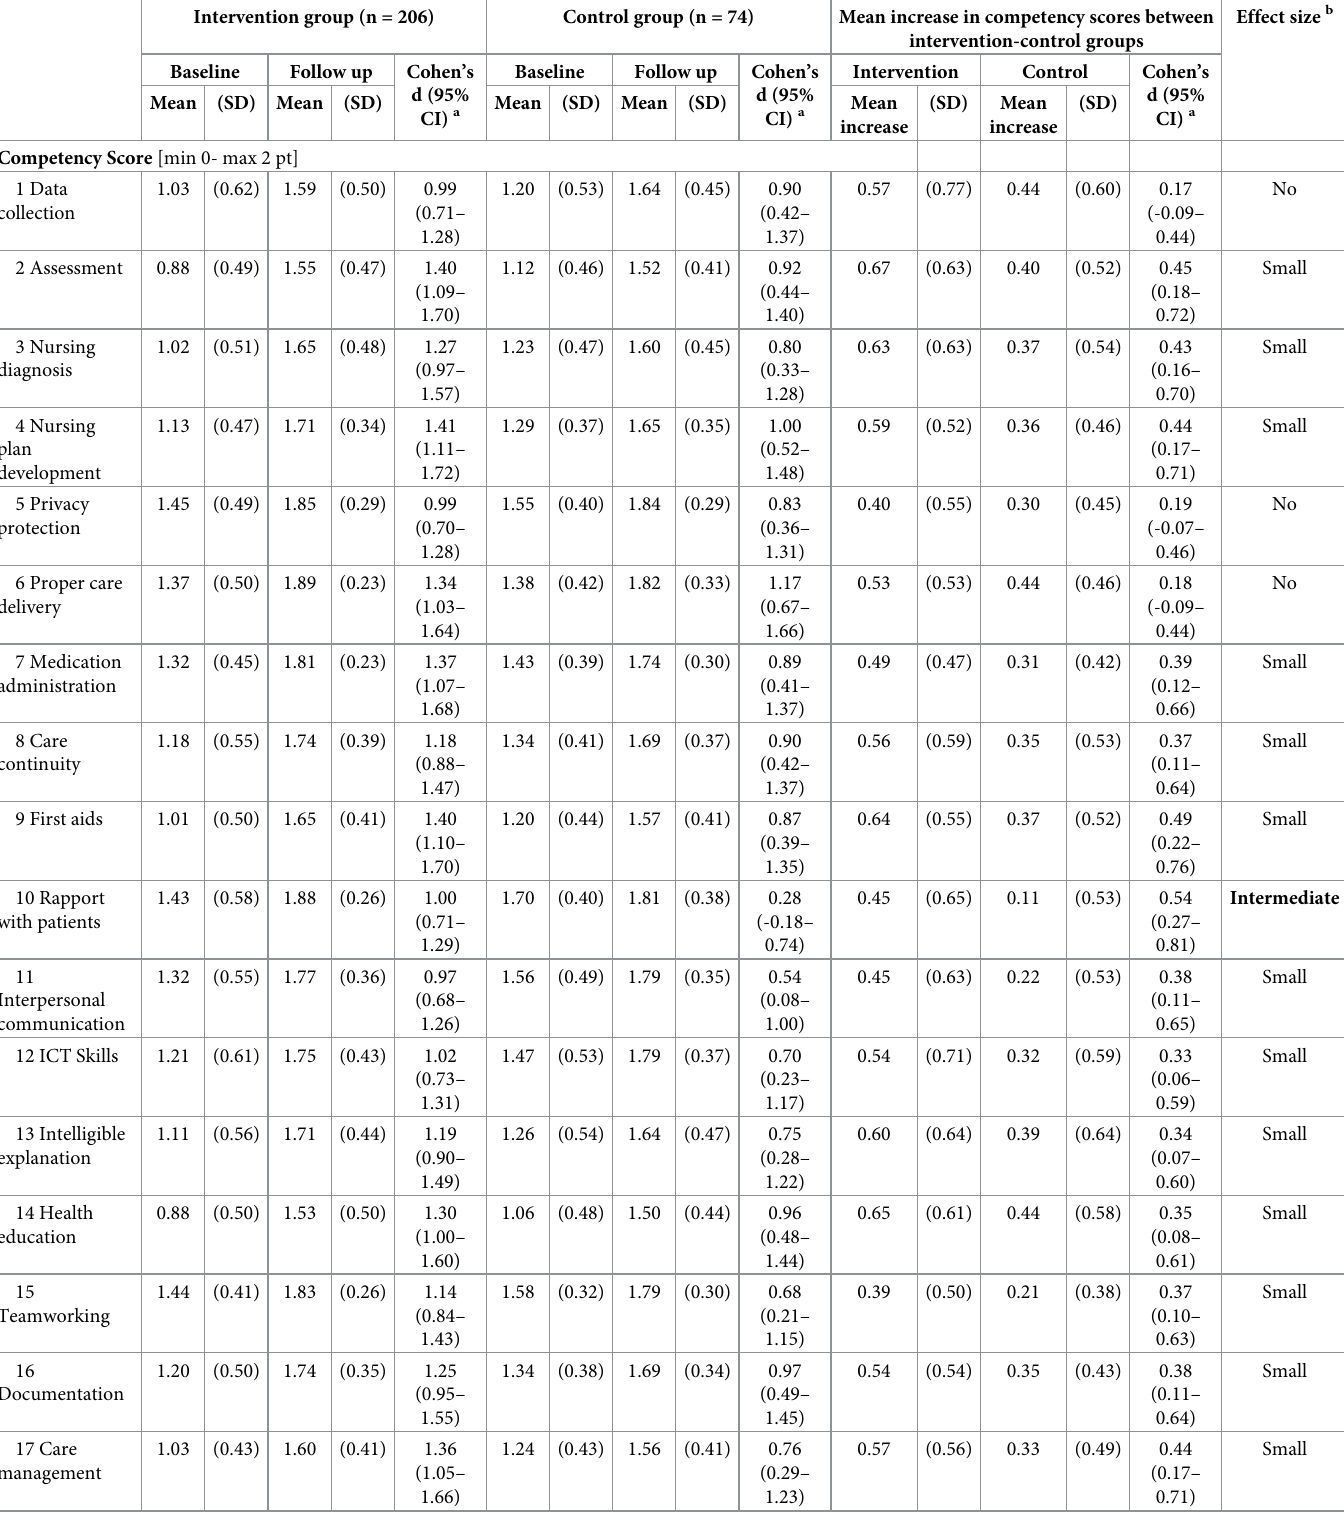
Effect size b intervention-control groups